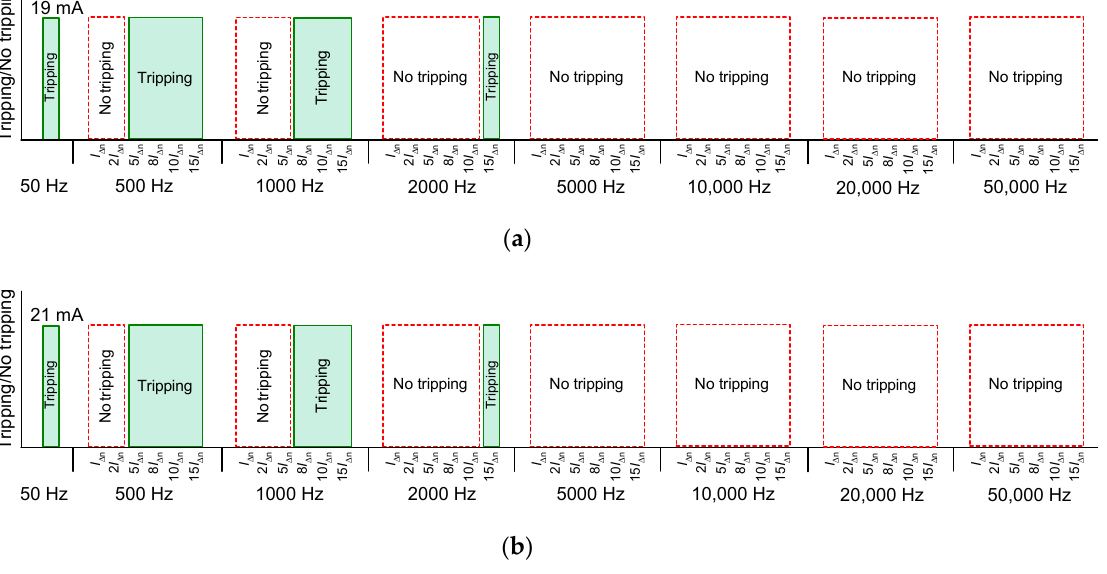
Figure 16. Tripping of the 30 mA B-type RCDs for a sine waveform of the specified frequency from 50 Hz to 50 kHz: ( a ) RCD_1B; ( b ) RCD_2B; symbols defined in Table 2.